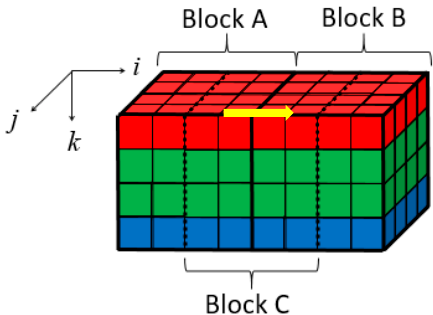
Figure 9. Location illustration of blocks A, B, and C.